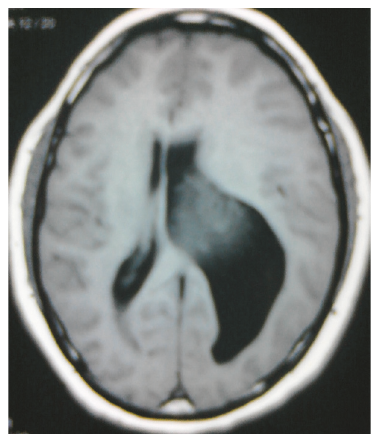
Figure 3: T1 image axial view precontrast film.